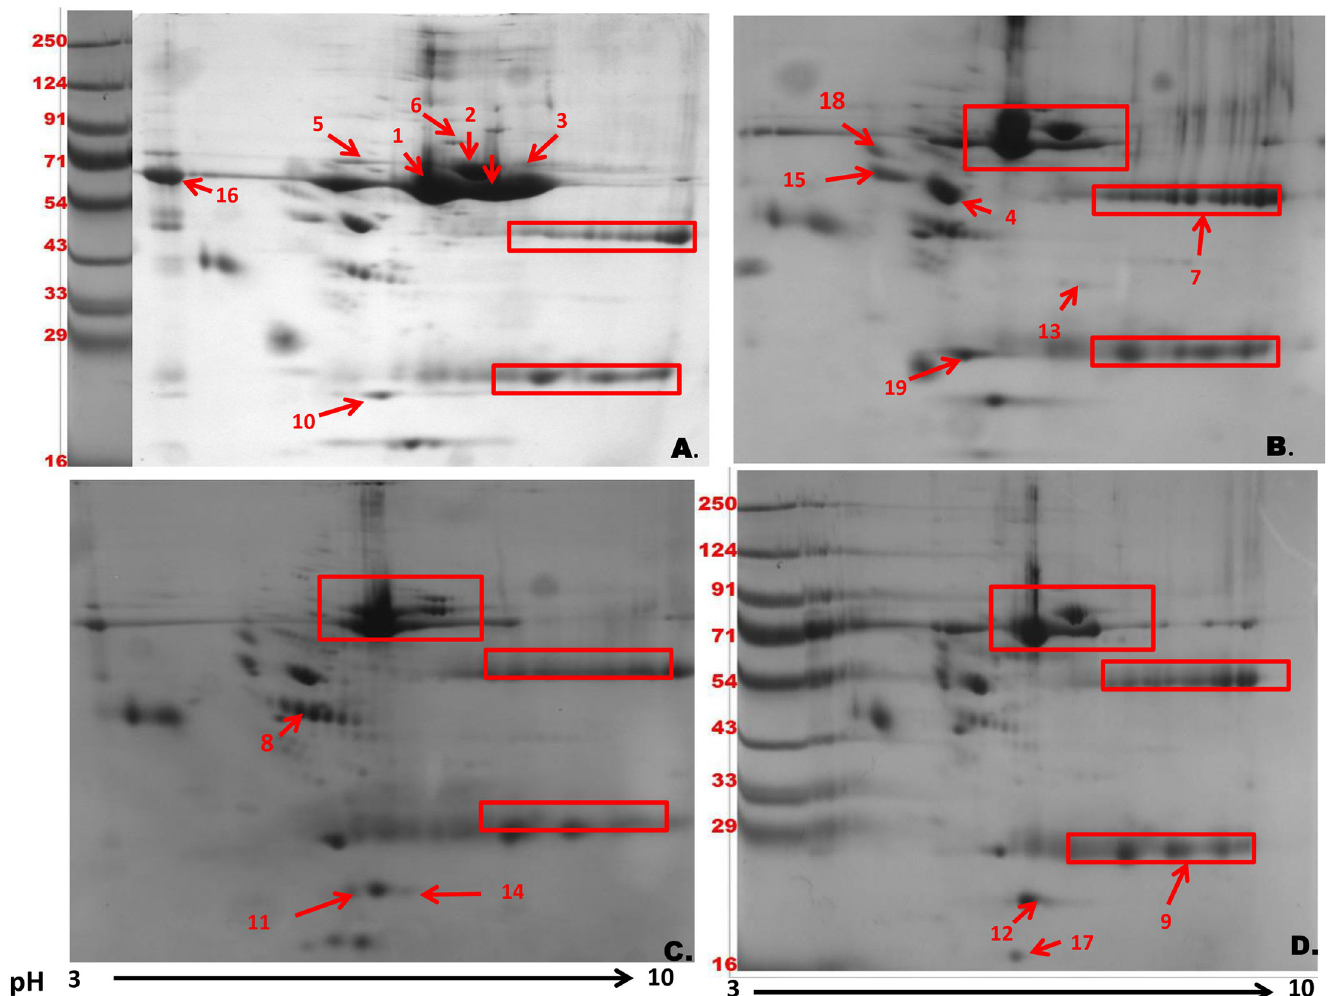
Fig 4. Differential expression of human serum proteins in normal and LF infected patients identified in 2DE analysis. Representative 2D gels of serum proteome form (A) Normal (n = 10), (B) Asymptomatic (n = 8), (C) Acute (n = 8) and (D) Chronic (n = 8) containing 400 μ g depleted serum proteins. Serum protein samples focused on linear pH 3–10 IPG strips and separated on 10% SDS-PAGE gels, were stained with colloidal Coomassie stain. Out of 19 deferentially expressed spots 13 spots are statistically significant (P � 0.05) and 6 spots were highly significant (P �